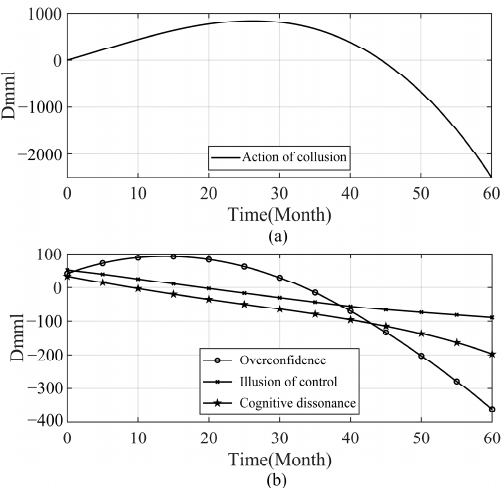
Figure 8. Evolution of cognitive biases and AC under the IGR change scenario. Subfigures ( a – d ) illustrate the OC, AC, CI, and CD curves under varied IGRs.